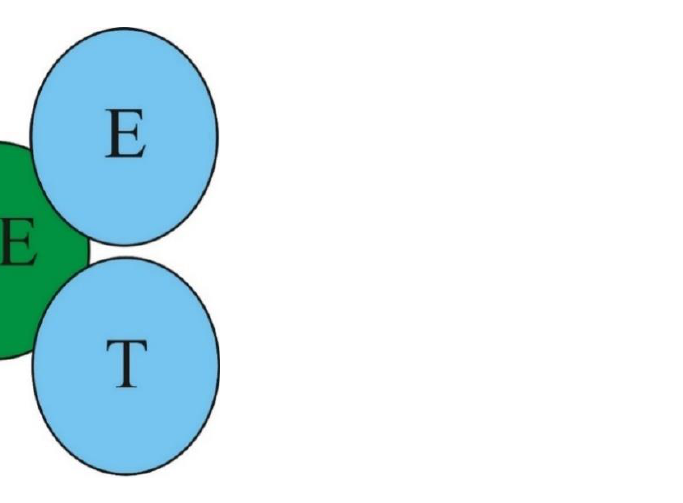
Figure 1. Utilized PEST analysis factors for RE macro-environment: P—political, E—economic, S—social, T—technological (author’s own work).